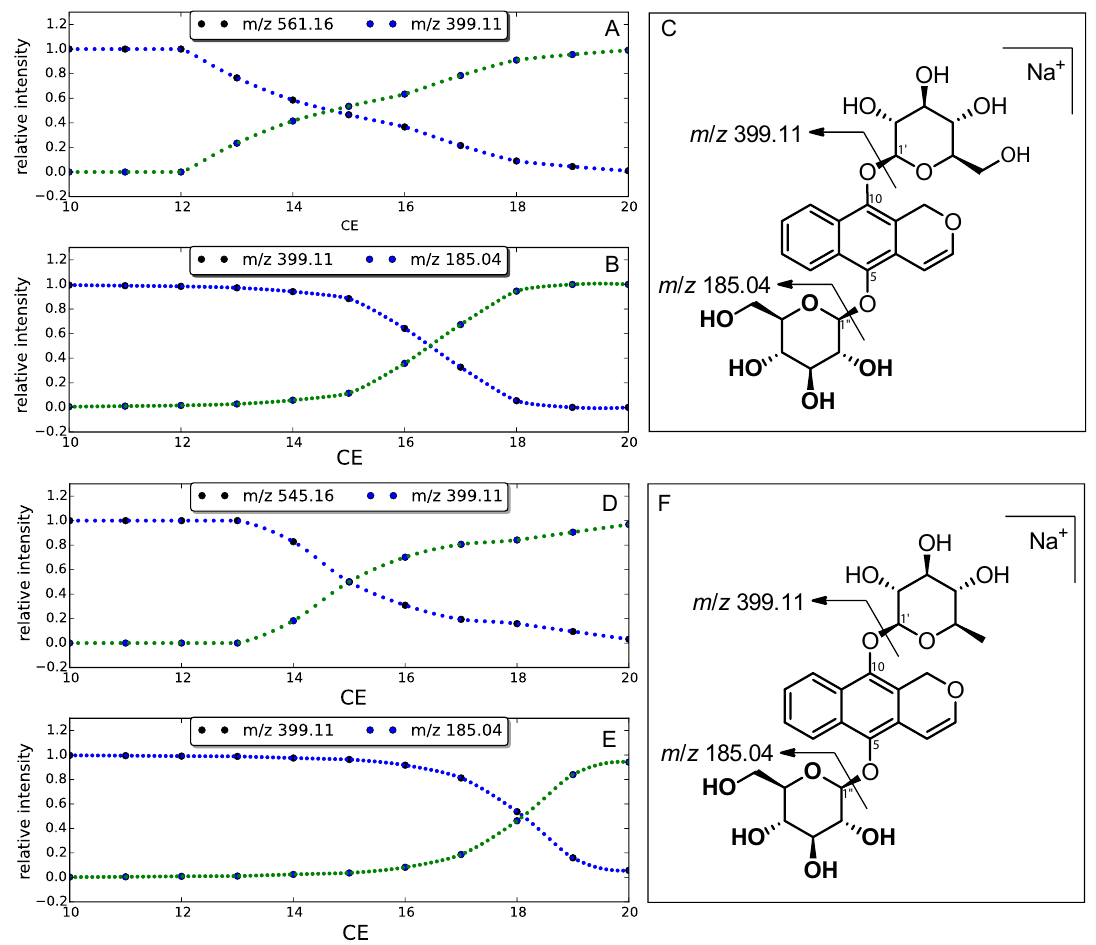
Figure 3. Plot of relative ion current vs collision energy corresponding to m / z 561.16 vs. 399.10 ( A ) and m / z 399.10 vs. 185.04 ( B ). ( C ) MS/MS fragments of 2 . Plot of relative ion current vs. collision energy corresponding to m / z 545.16 vs. 399.10 ( D ) and m / z 399.10 vs. 185.04 ( E ). ( F ) MS/MS fragments of 1